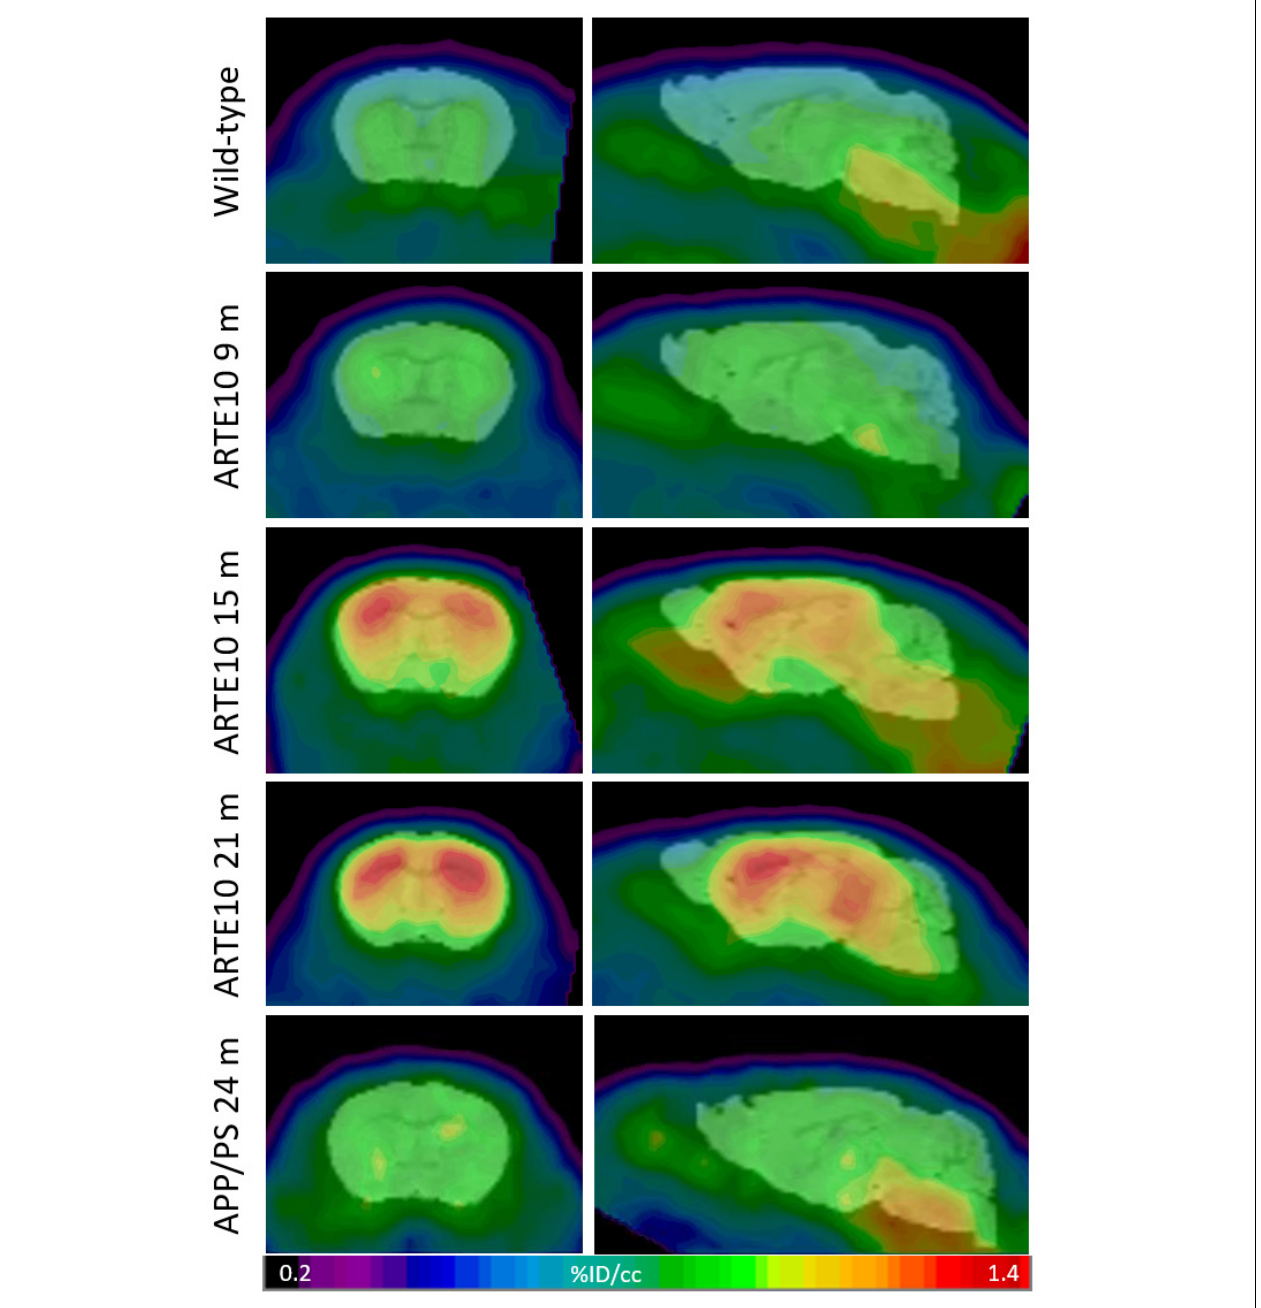
FIGURE 1 | Progressive FBB retention in the brains of ARTE10 and APP/PS mice. Wild-type control animals, homozygous ARTE10 mice at the age of 9, 15, or 21 months, and 24-month-old APPswe/PS1 (cid:49) E9 (APP/PS) were subjected to FBB PET. Coronal (left) and sagittal (right) views of cranial tracer retention (% injected dose per volume, %ID/mL) averaged over 25–90 min post-injection. Representative animals are shown coregistered to a mouse brain MRI atlas.